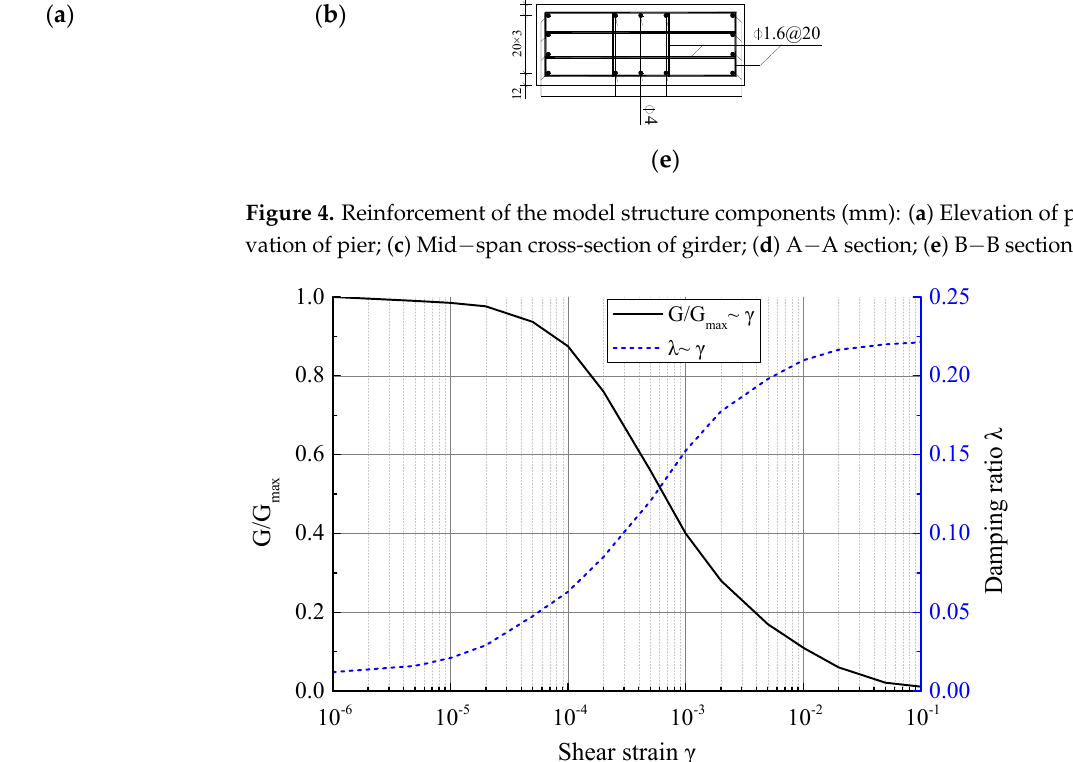
Figure 5. Dynamic characteristics of the model soil.